Question: What caption would you write for this figure?
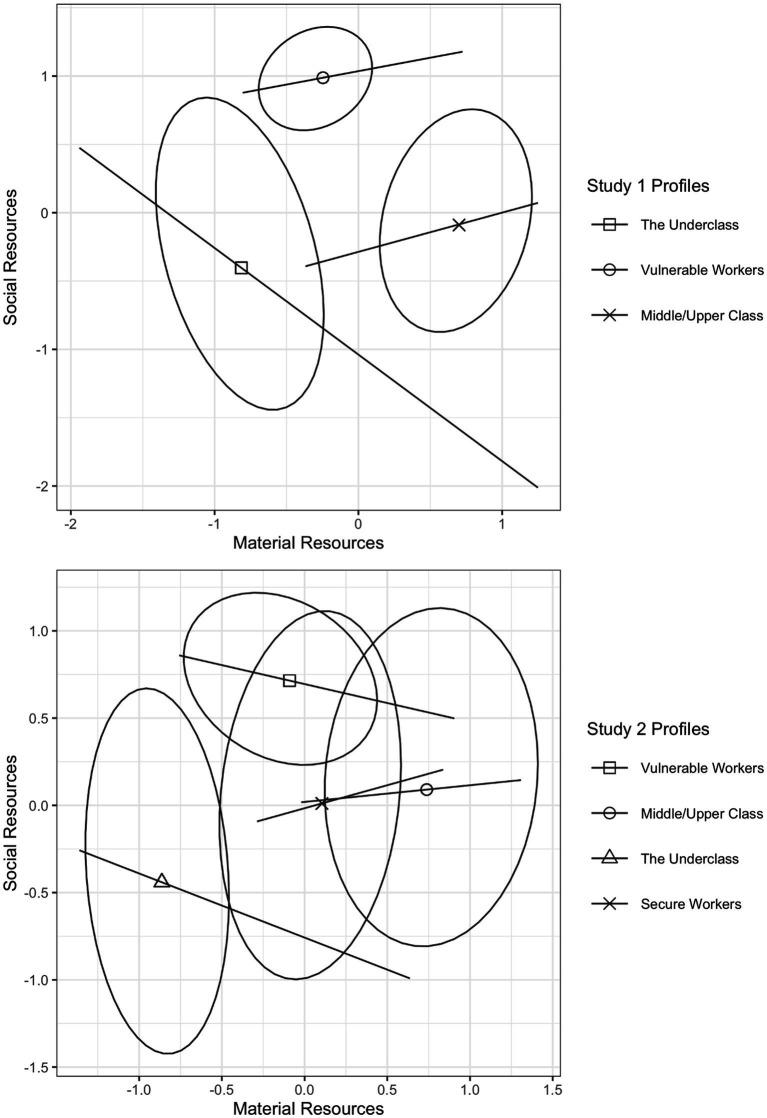
Answer: Social-class profile means and within-profile associations between material resources and social support in studies 1–2.